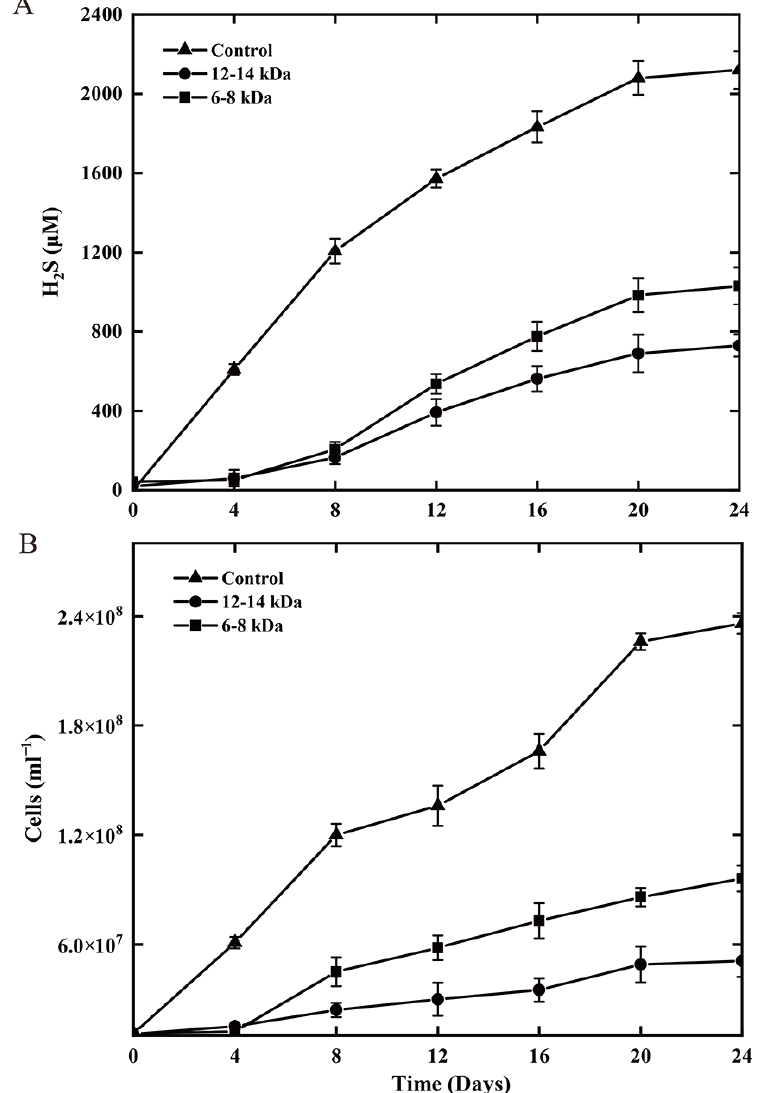
Figure 5. Sulfide concentrations ( A ) and cell densities ( B ) in cultures of strain ST-419 grown chemolithoautotrophically with H 2 as the sole electron donor and S 0 as the sole electron acceptor. S 0 was provided in the bulk medium (control) or was sequestered in dialysis membranes (pore sizes of 6 to 8 kDa or 12 to 14 kDa) to prevent physical contact with the bulk S 0 .